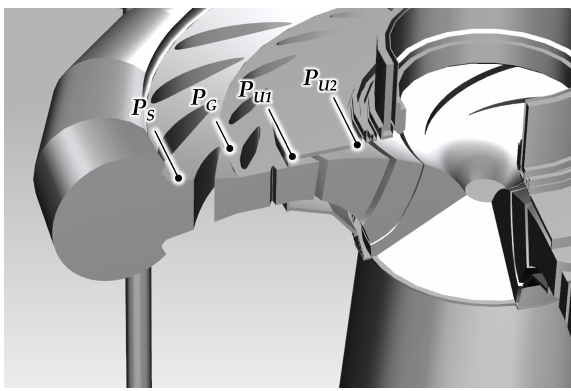
Figure 6. Pressure monitoring points’ selection.